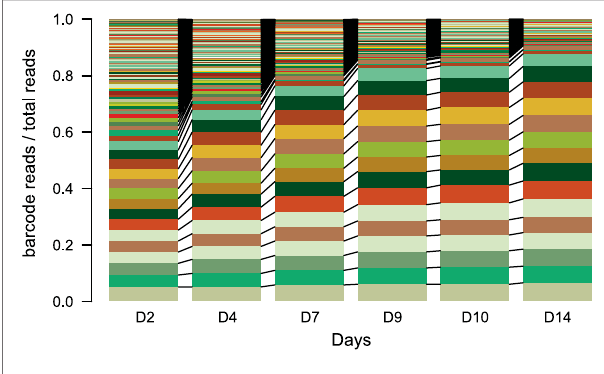
FIGURE 4 | IPR expansion and drift over time. Stacked barplot of the percentage of reads each barcode represents over time (days). Each color represents a different barcode (IPR) that are linked between the plots N (cid:1) 1. Over the time course of the experiment samples were taken from a TRIP cell pool and processed as for scoring indels. The barcodes were retrieved from the indelPCR data, counted and their proportion was plotted per